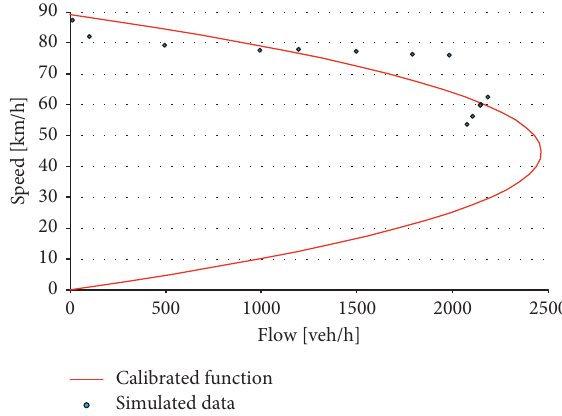
Figure 6: Calibrated function f � f ( v ) in the case of network configuration 1 for the interfaceable solution.